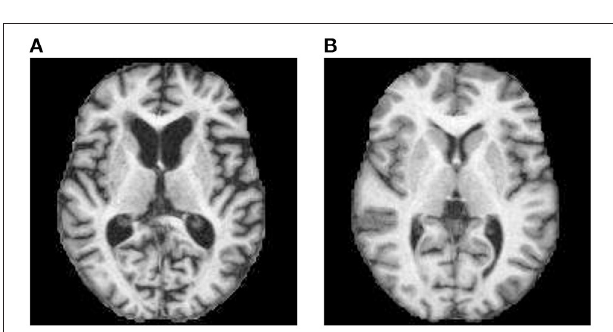
FIGURE 4 | Samples of our dataset. (A) AD, (B)